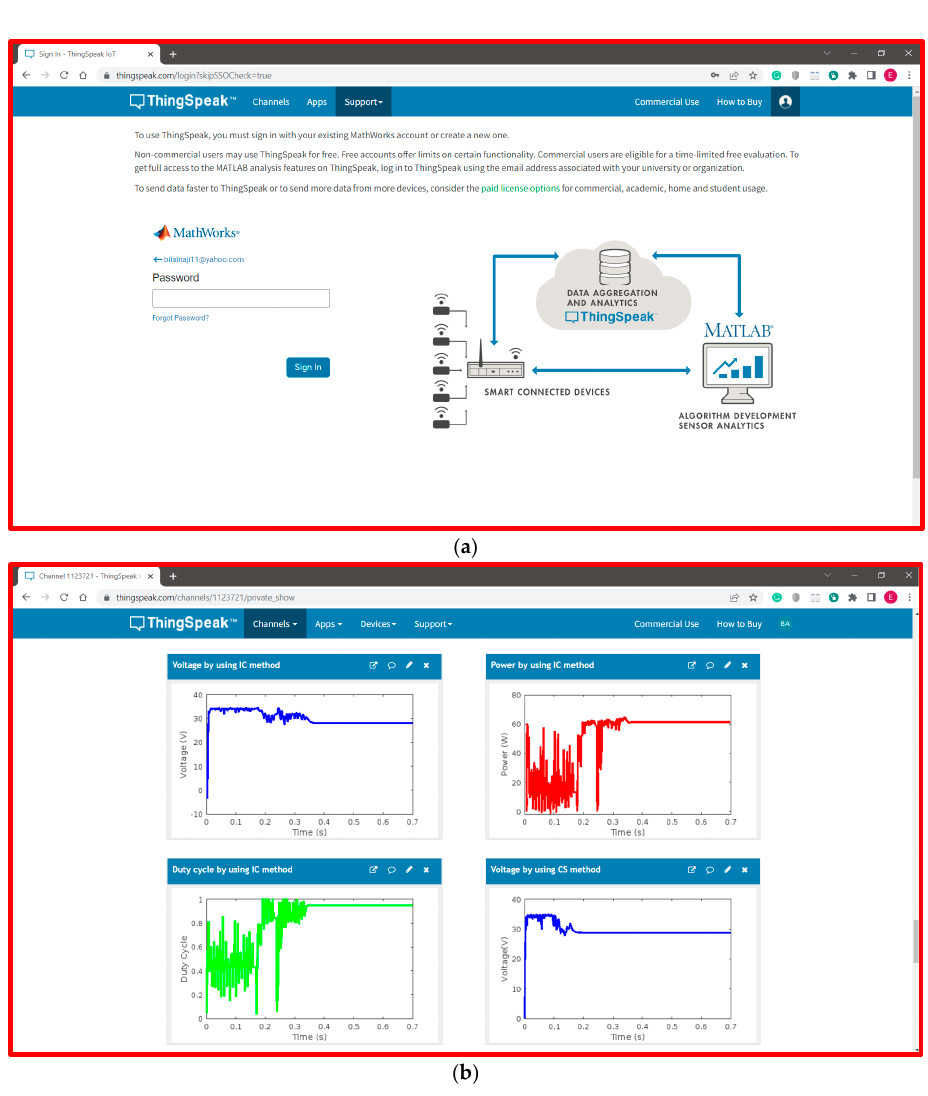
Figure 12. Supervisory Control and Data Acquisition (SCADA), ( a ) dashboard after the enter username and password, ( b ) user interface design platform A graphical user interface (GUI) was part of the suggested system to help users comprehend the overall voltage and power used. Figure 13 represents power consumption, voltage, and the duty cycle using the incremental conductance method as shown in [39]. Figure 14 shows the SCADA graphical user interface, (a) the voltage, (b) the power, and (c) the duty cycle using the incremental conductance method. Figure 15 shows the power consumption, voltage, and duty cycle using the cuckoo search method. Figure 16 shows the SCADA graphical user interface, (a) the voltage, (b) the power, and (c) the duty cycle using the cuckoo search method. Figure 17 shows the power consumption, voltage, and duty cycle using the IABC method. Figure 18 shows the SCADA graphical user interface, (a) the voltage, (b) the power, and (c) the duty cycle using the IABC method.